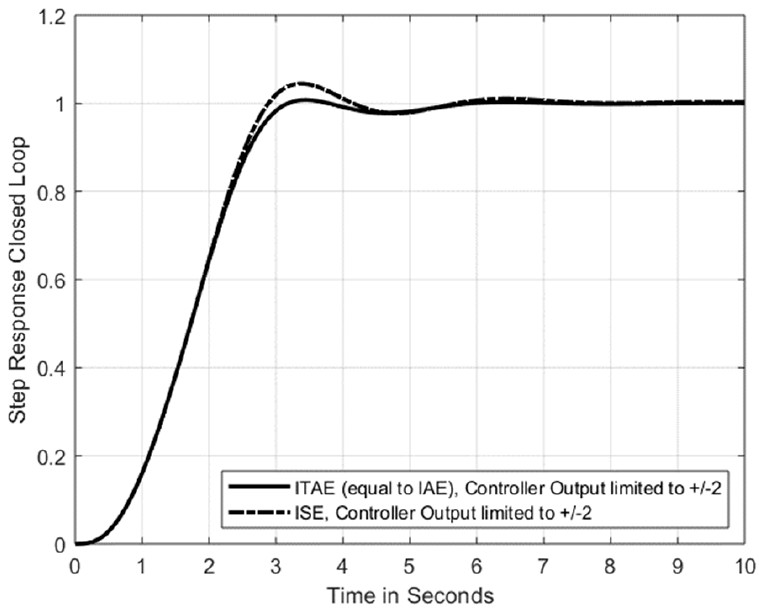
Figure 7. Step response of the controlled PT3 system of Example 1.